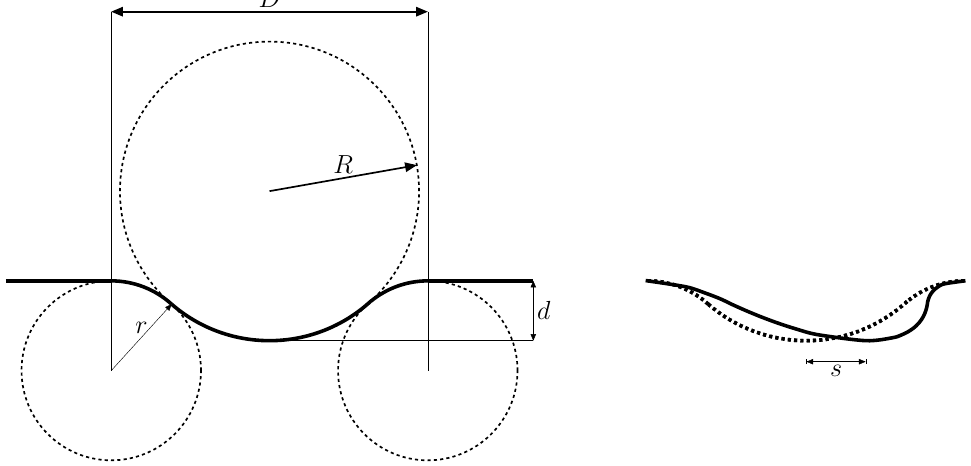
Figure 1. Cross section of the parametric dimple geometry ( left ) and streamwise shift of the deepest point ( right